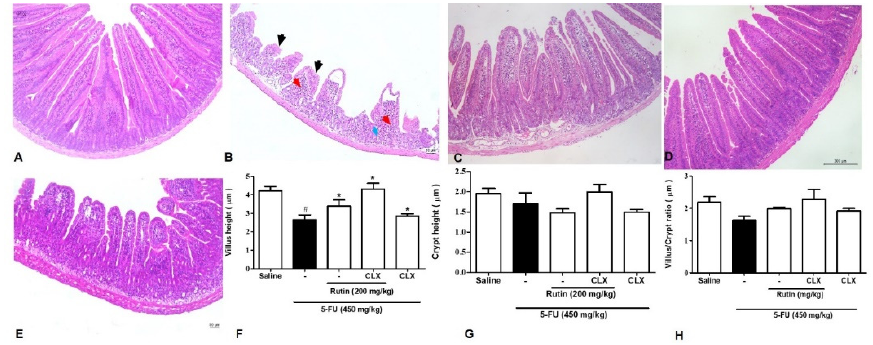
Figure 11. Effect of RUT on the COX-2 pathway evaluated by histopathological and morphometric analysis in jejunal sections. hematoxylin and eosin (H&E) staining was performed for morphometric and histopathological analysis of tissues after incubation with celecoxib. Saline ( A ); 5-FU ( B ); RUT-200 ( C ); CLX ( D ); RUT and CLX ( E ); Height of villi ( F ); Depth of crypts ( G ); Villus / Crypt ratio ( H ). The histopathological issues are indicated by arrows. Inflammatory cell infiltration (red arrow), decreased intestinal villi (black arrow), and loss of intestinal crypt architecture (blue arrow). Values are expressed as mean ± SEM. For statistical analysis, one-way ANOVA was used, followed by the Tukey test. # p < 0.05 vs. saline group, * p < 0.05 vs. 5-FU group. 5-FU, 5-fluorouracil; RUT, rutin.